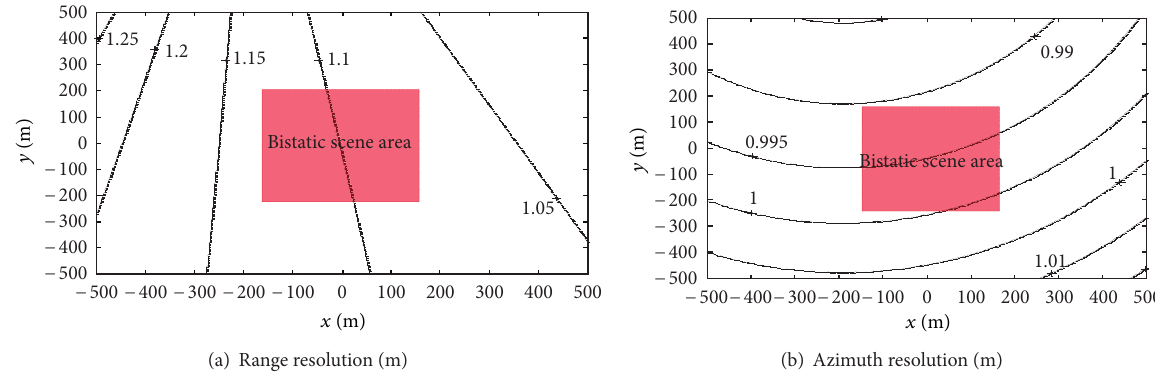
Figure 9: Range resolution in meters (a) and azimuth resolution in meters (b) of GEO-UAV BiSAR in xOy plane ( 𝑡 0 = 𝑇 𝑠 /8 ). The red region represents the bistatic scene area.